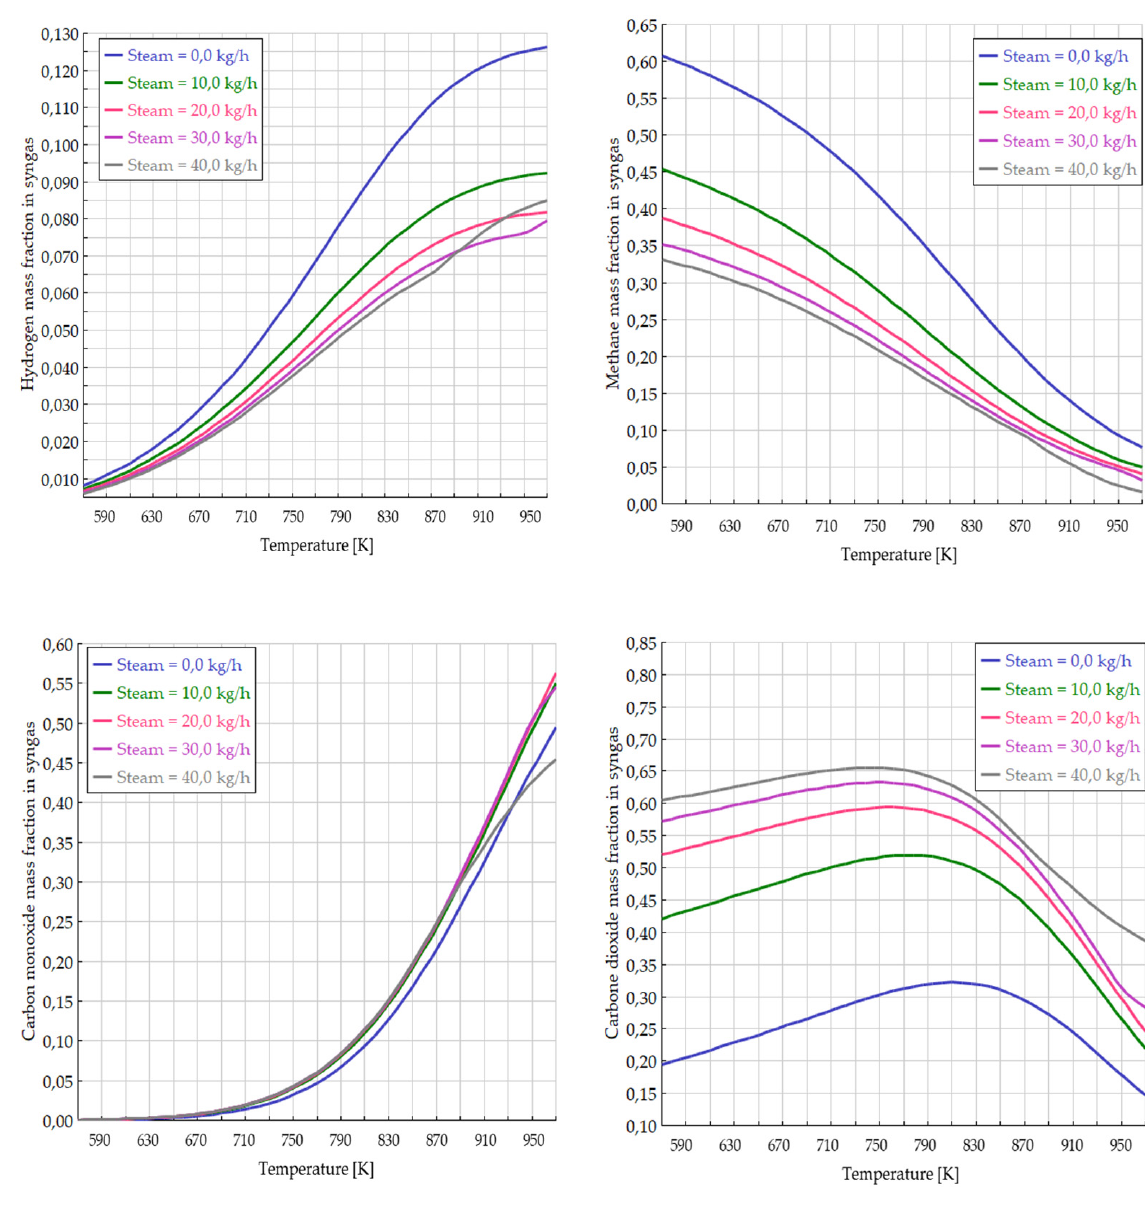
Figure 9. The effect of temperature over syngas composition for different steam streams (a feed stream of 100 kg/h).